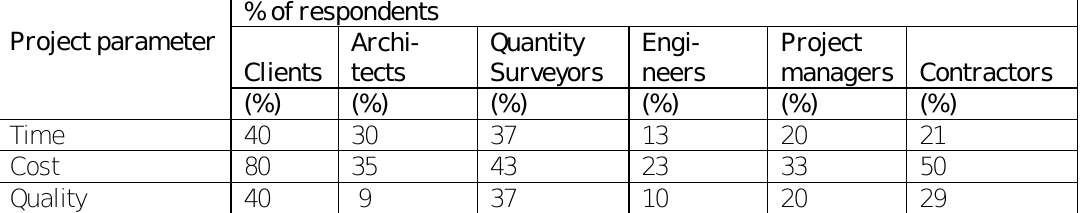
Table 6: Perceptions of whether all or most clients use their own resources to monitor